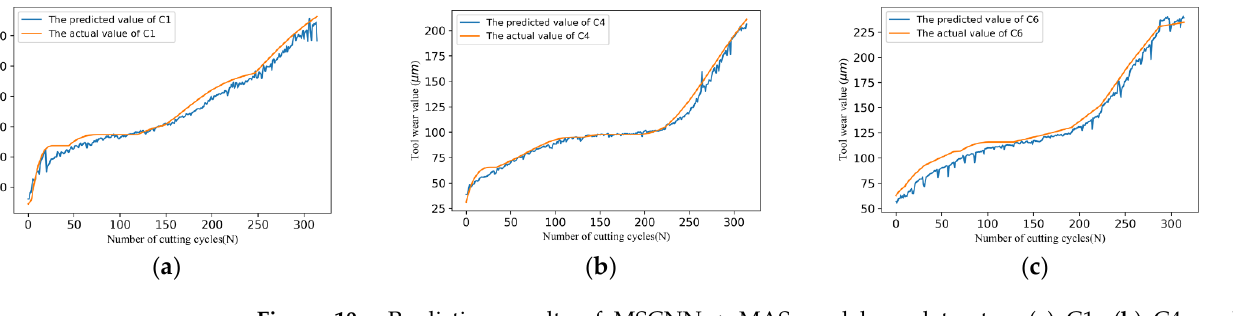
Figure 9. Prediction results of MSCNN+ ELCA model on datasets. ( a ) C1, ( b ) C4, and ( c ) C6. 𝑃 𝑀𝐴𝐸 = 5.44 , 𝑃 𝑀𝑆𝐸 = 50.71 .